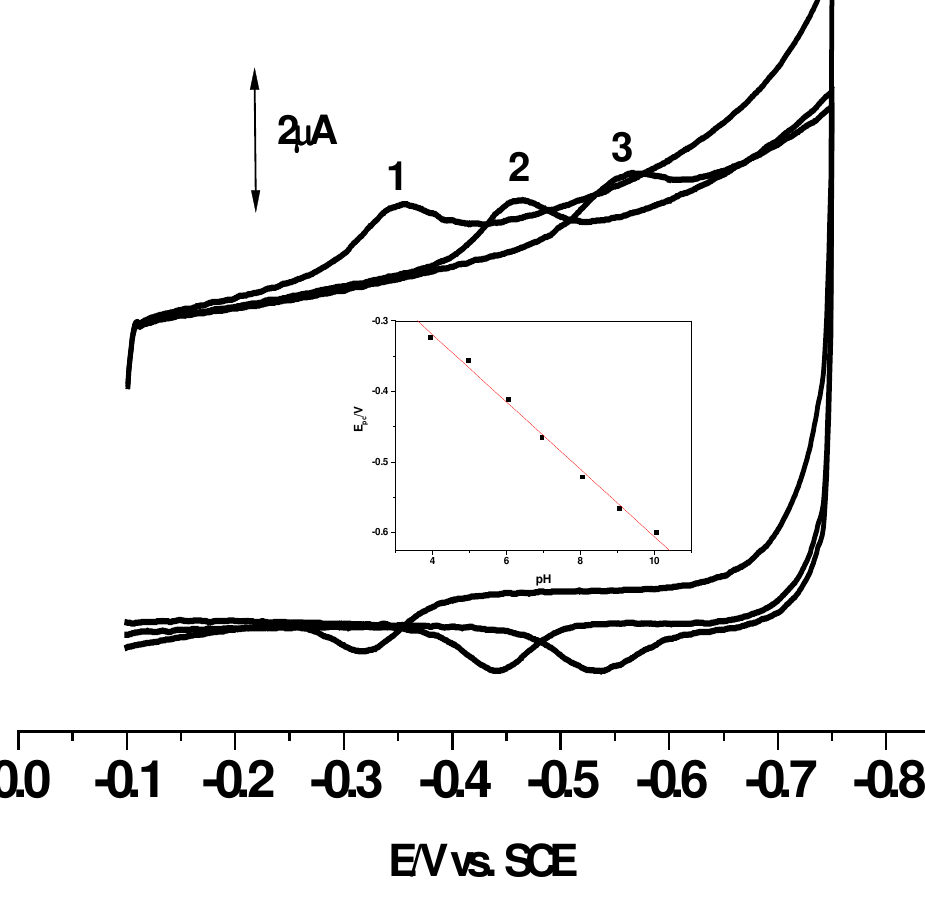
Fig.3. Cyclic voltammograms of glucose oxidase (1.0 ×10 -4 M) at a SWNT-midified gold electrode in 0.05M phosphate buffer at pH values of (1)5.0, (2)7.0, (3)9.1. The inset shows the relationship between the reduction peak current E employed was 0.1Vs -1